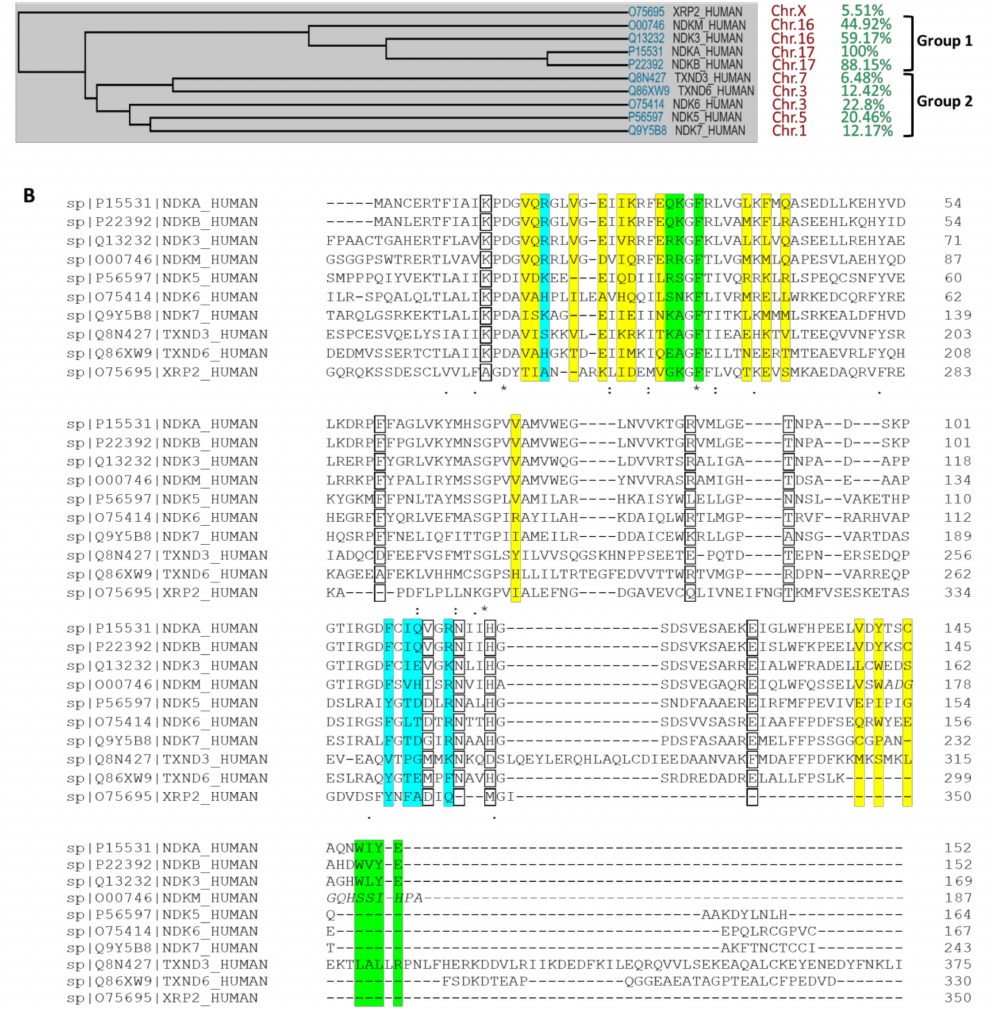
Figure 1. Global comparison of human NME family members. NME1 to 10 correspond respectively to NDKA, NDKB, NDK3, NDKM, NDK5, NDK6, NDK7, TXND3, TXND6 and XRP2. ( A ) Evolutionary tree from the sequence alignment of the 10 NME proteins in humans using the Uniprot database. Their respective gene localization is provided, as well as the protein sequence identity based on NME1 (NDKA) as reference. ( B ) Catalytic site in protein sequence alignment of human NME1 to NME10. Uniprot IDs of each gene encoding human NME1-10 are shown at the start of each line. Residues lying in the active site are highlighted with boxes. Residues that are responsible for forming large interface, small interface 1, and small interface 2, are highlighted in yellow, cyan, and green, respectively. Residues identical in all aligned NMEs are labeled by an asterisk (*), whereas a colon (:) and a period (.) indicate strongly similar and weakly similar sequences, respectively. Several amino acids missing in the NME4 crystal structure (Protein Data Bank (PDB) ID: 1EHW) due to the weak density are shown in